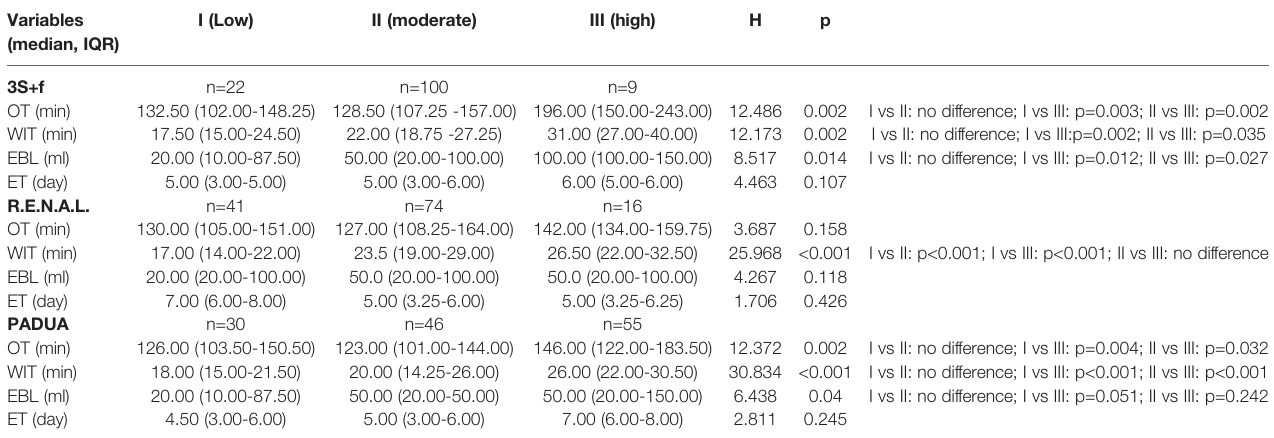
TABLE 4 | Krustal-Wallis test of different nephrometry score systems ’ categorized scores.